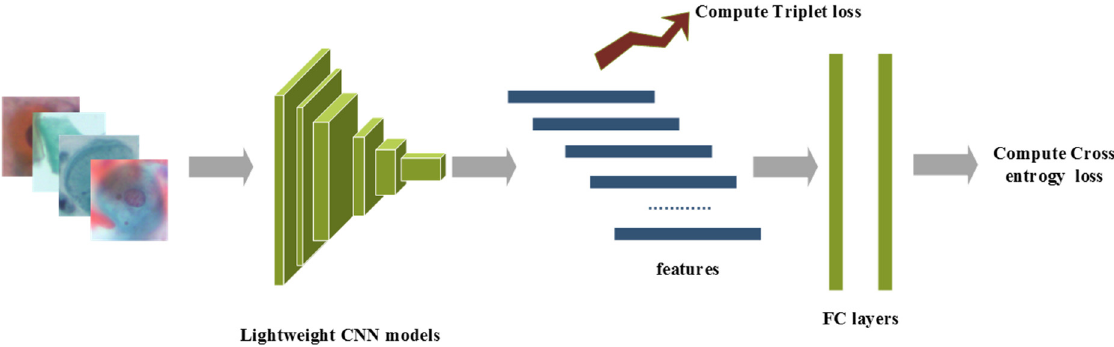
Figure 1. The overview of the proposed method.